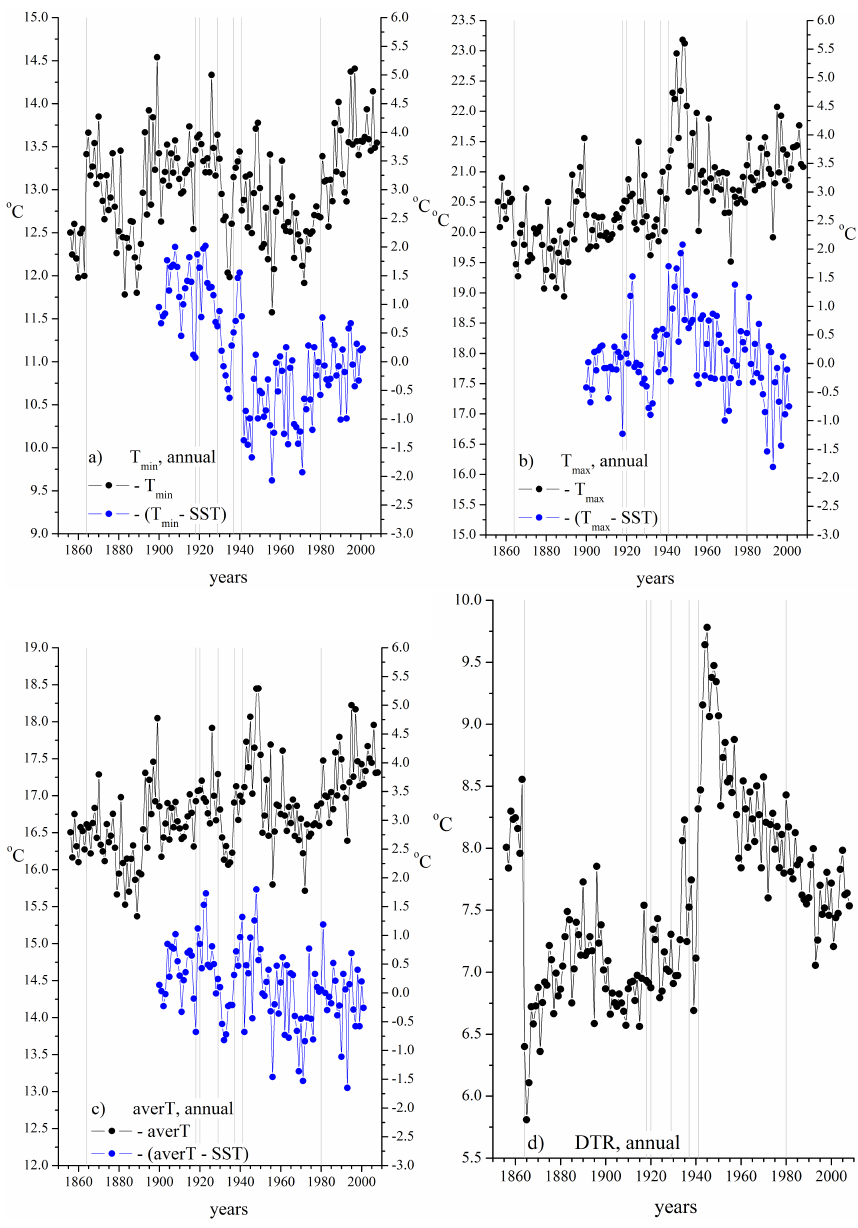
Figure 11. Lisbon: annual variations of T min (a) , T max (b) , T aver (c) and DTR (d) ; temperature series are shown in black, di ff erences between temperature and SST Lisbon series are shown in blue. Grey vertical bands show dates of known instruments relocation (see Table 3).